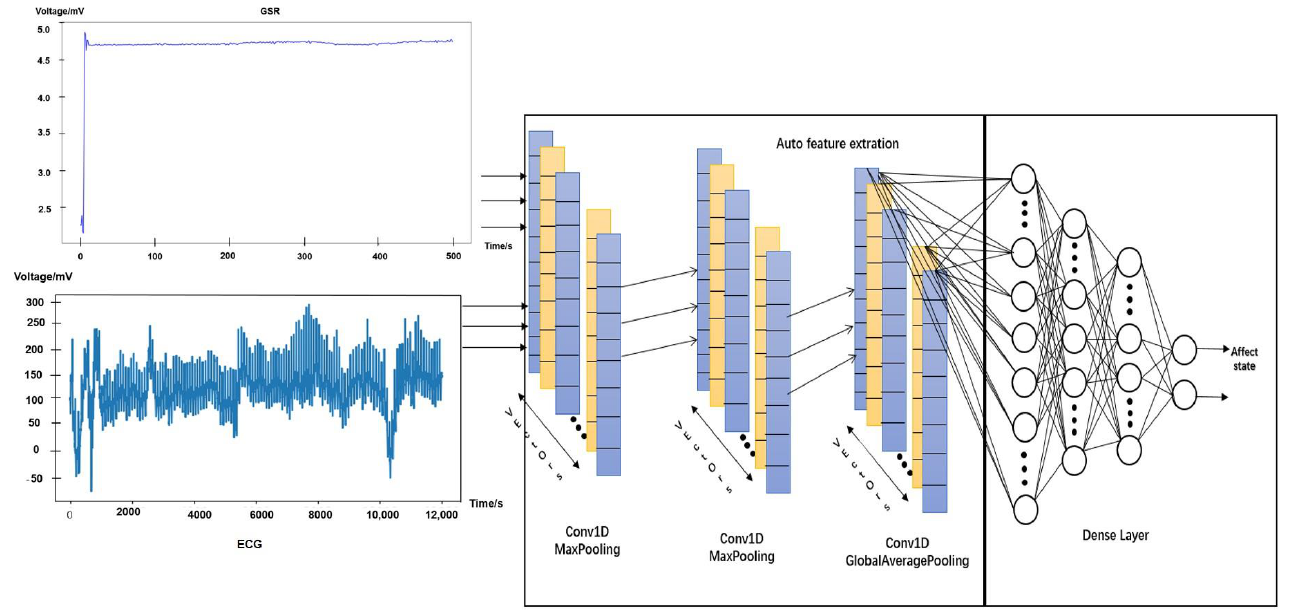
Figure 2. Schematic diagram of deep convolutional neural network.